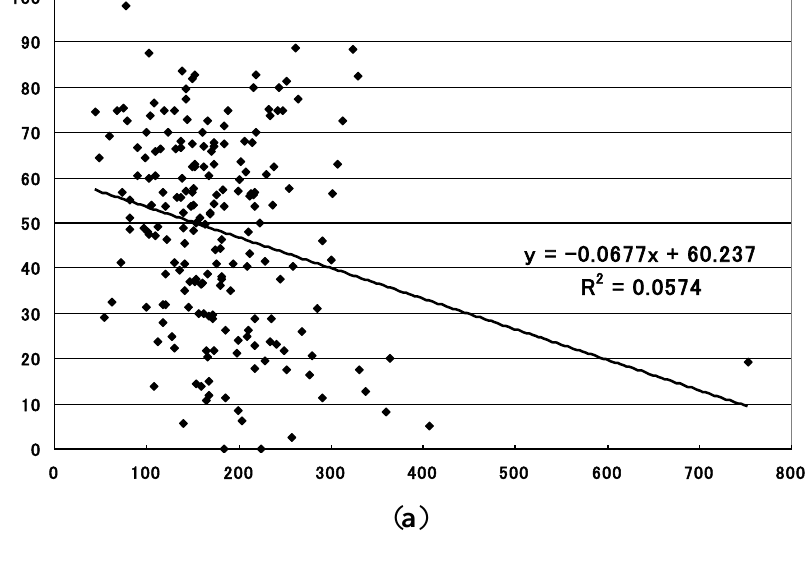
Figure 5. Relationship between summertime precipitation and sero-conversion rate to JE virus in sentinel pigs in the region 3 (west region). ( a ) Statistically significant inverse relationship with the mean sero-conversion rate ( p = 0.001). X-axis: precipitation during the period (mm), Y-axis: sero-conversion rate to JE virus (%); ( b ) Statistically significant inverse relationship with the maximum sero-conversion rate ( p = 8.490 × 10 −6 ). X-axis: precipitation during the period (mm), Y-axis: sero-conversion rate to JE virus (%).